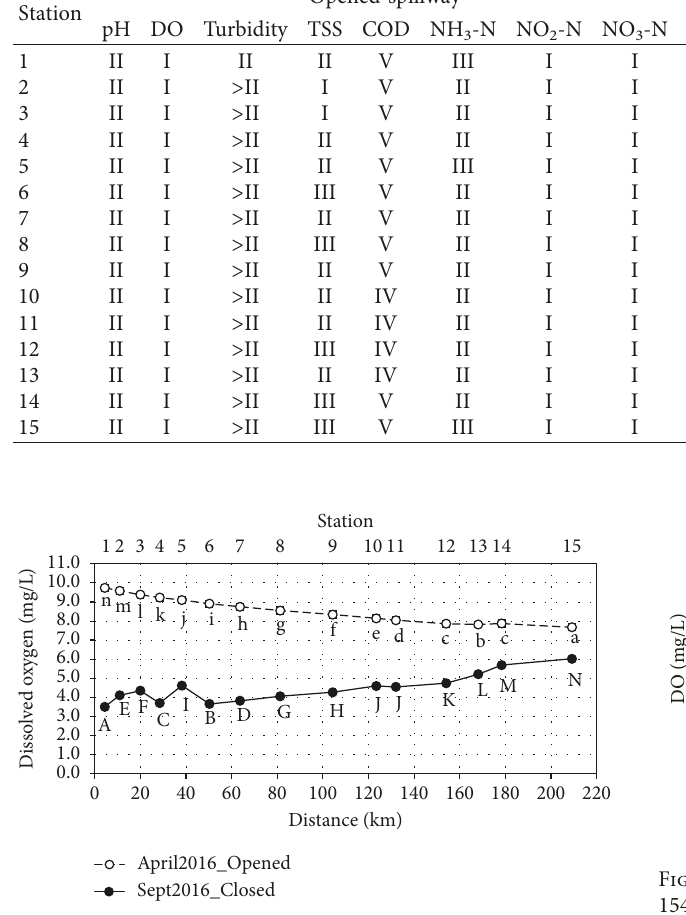
Figure 4: Dissolved oxygen at the 15 stations downstream of Bakun Hydroelectric Dam during opened spillway ( o ) and closed spillway ( • ). The same letter indicates no significant difference ( p > 0 . 05).